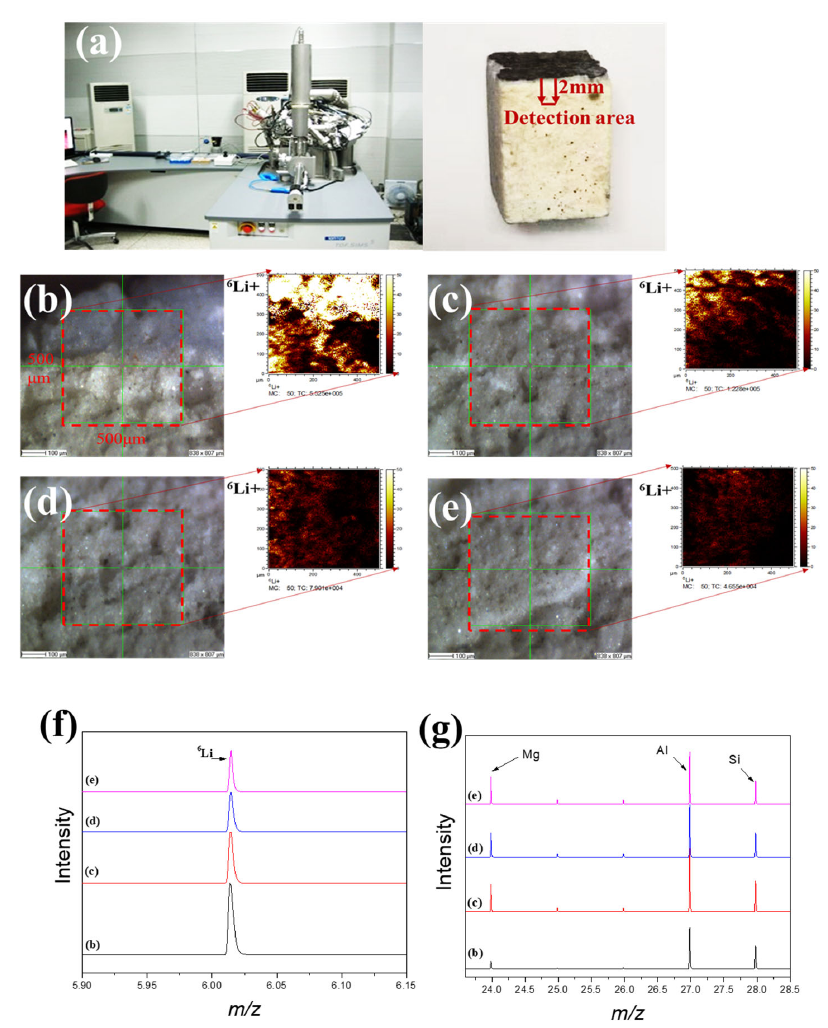
Figure 5. TOF-SIMS lithium permeation analysis of waste saggar. ( a ) TOF-SIMS instrument and analysis sample; ( b – e ) local scanning images and lithium intensity distribution maps, respectively, obtained from the surface of the adhesive layer of waste saggar in a scanning analysis area of 500 μ m × 500 μ m. ( f ) and ( g ) Relative content changes in Li, Al, Si, and Mg in four different regions of b, c, d, and e, respectively.